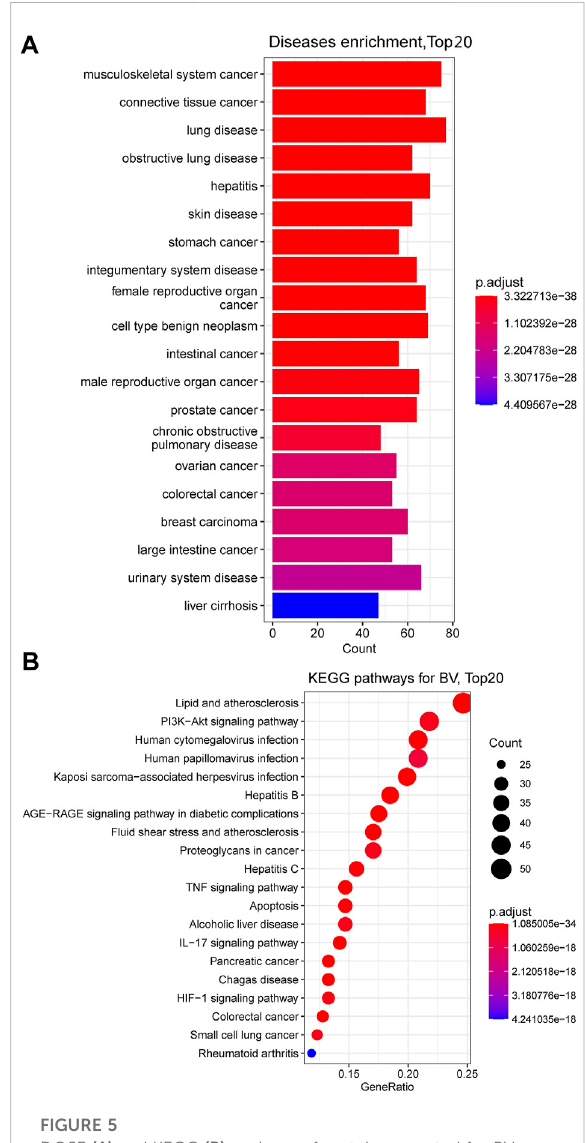
FIGURE 5 DOSE (A) and KEGG (B) analyses of proteins reported for BV and its main components in the literature. Top 20 diseases and KEGG pathways are enriched using R package “ DOSE ” and “ topGO ” , respectively with p -value Cutoff = 0.01, q-value Cutoff =